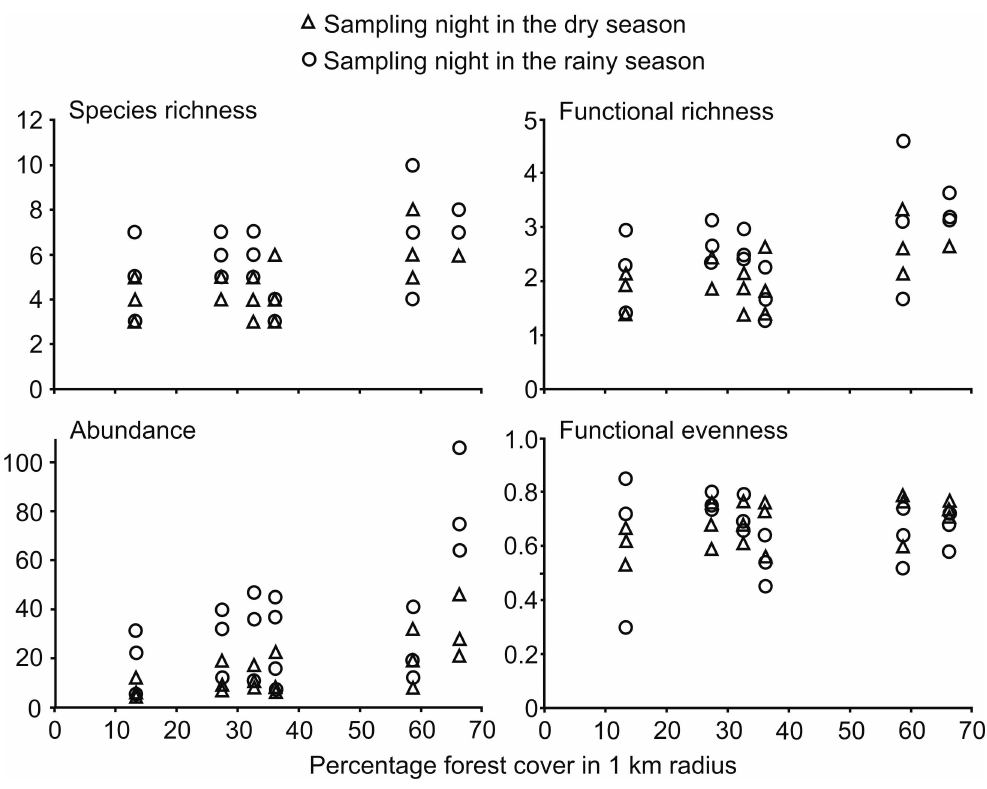
Fig 1. Bat community parameters per sampling night in relation to forest cover in the Huastecaregion, Hidalgo, Mexico. As an example,forest cover is shown when it is measuredin the buffers of 1 km radius around samplingsites, given that all the results are consistent at the 3 measuredspatialscales. Six samplingnights were carried out at each one of the six sites (total n =